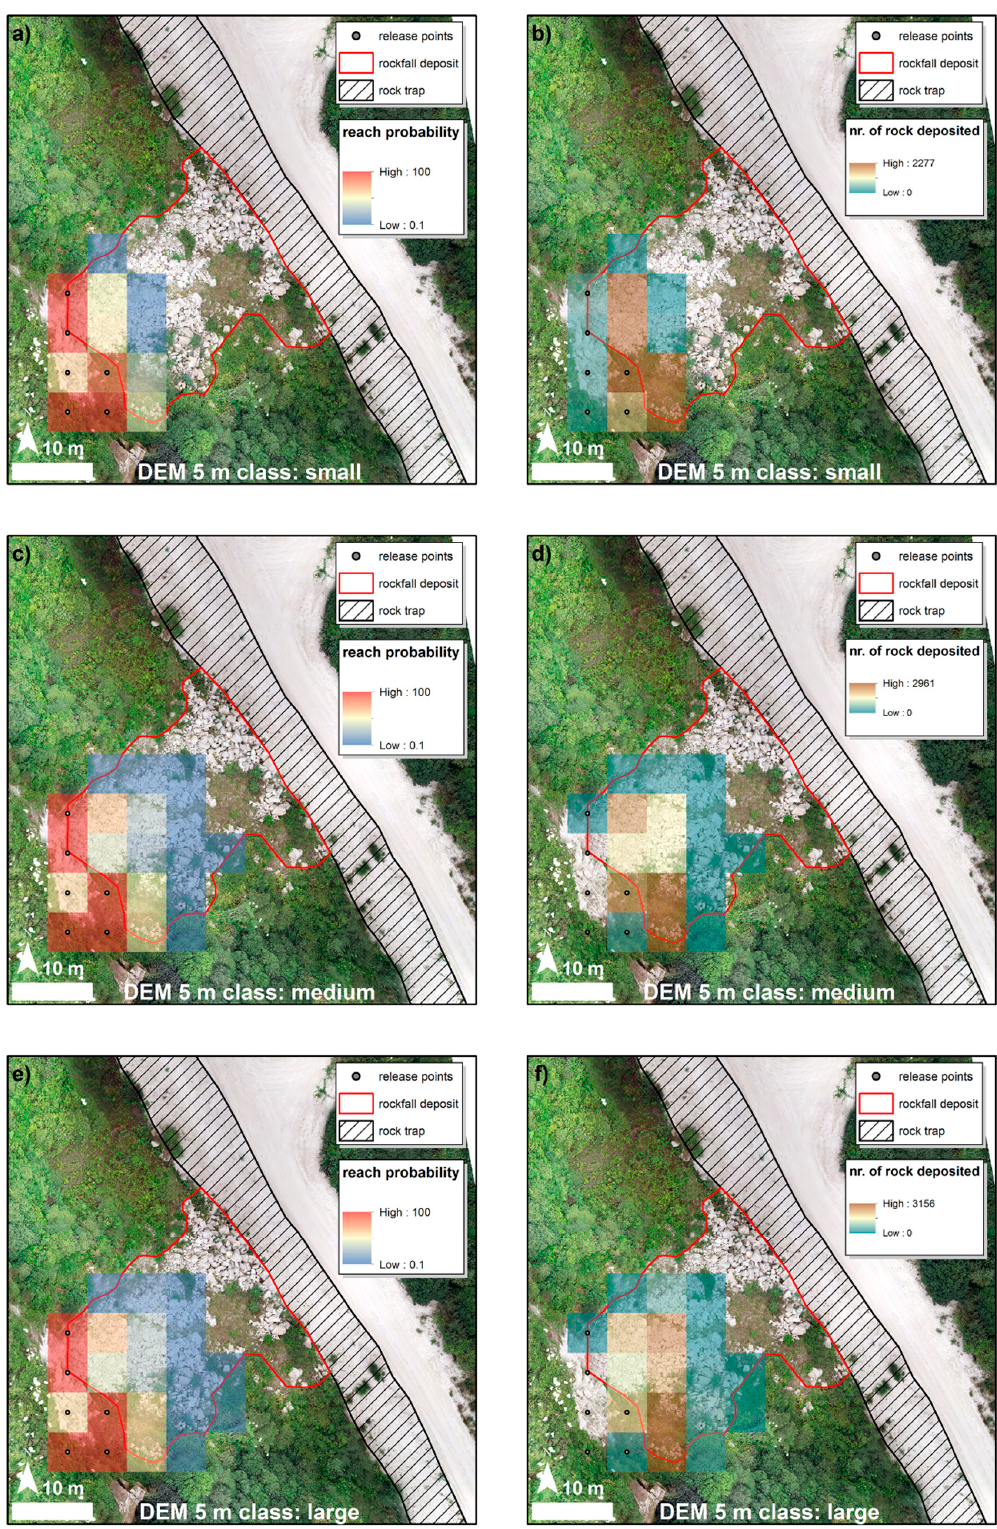
Figure 10. Rockyfor3D results computed on the 5 m resolution DEM. Left hand images ( a , c , e ) show the reach probability layers, on the right ( b , d , f ) the number of rocks deposited. The first row shows ( a , b ) results obtained with the rock class ‘SMALL’, second row ( c , d ) with ‘MEDIUM’ and the third row ( e , f ) with ‘LARGE’. Rock block classes’ properties are summarised in Table 5.